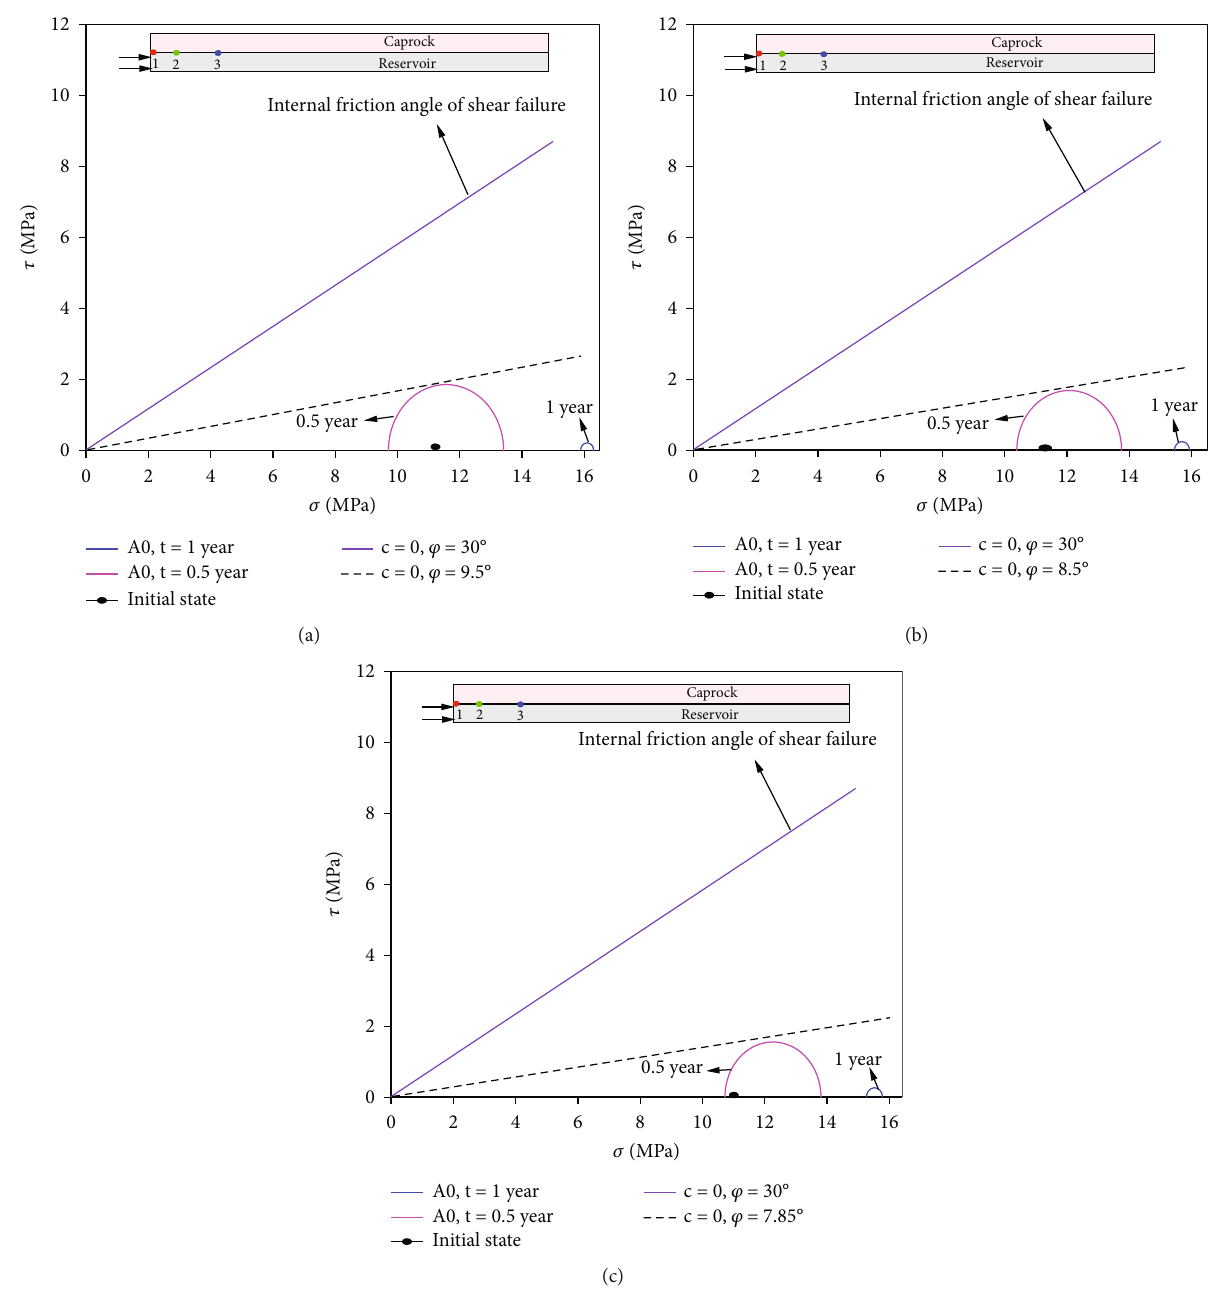
Figure 27: Mohr ’ s circle of stress. (a) Point 1. (b) Point 2. (c) Point